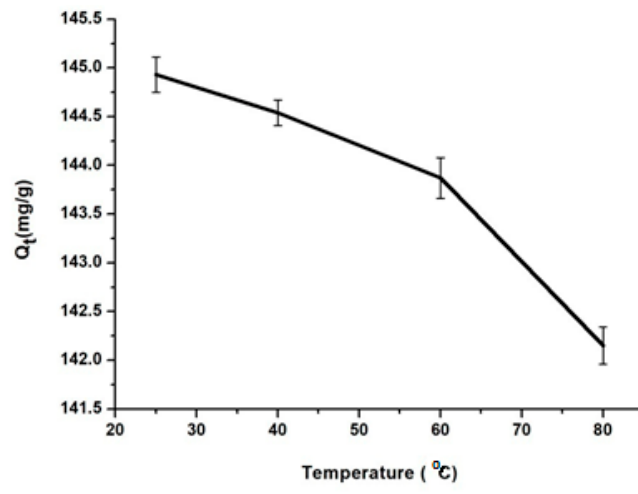
Figure 5. Adsorption of BZC at different temperature onto MSN.